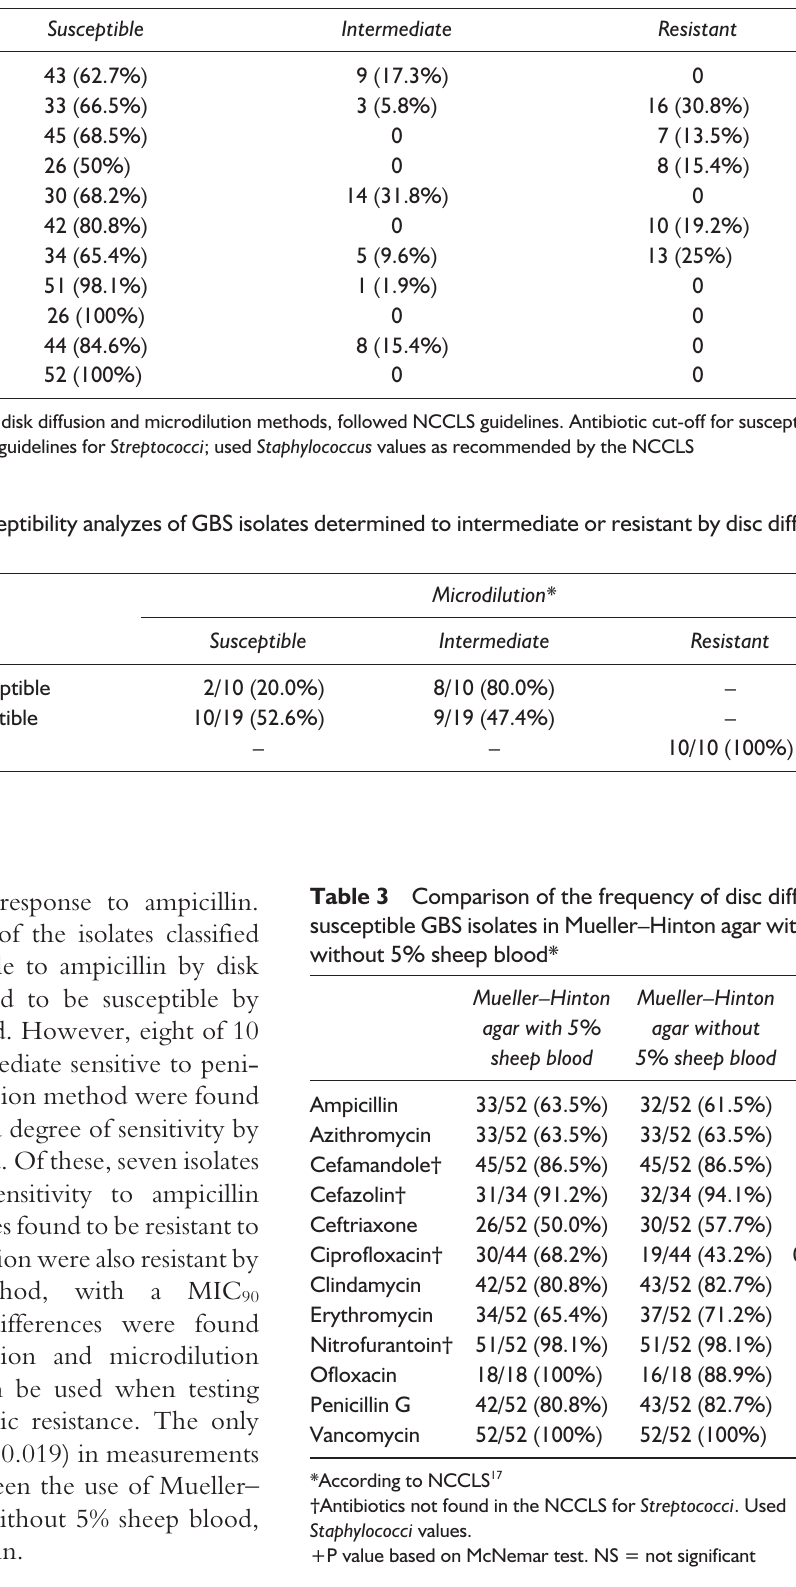
Table 1 Susceptibility profile of GBS isolates*